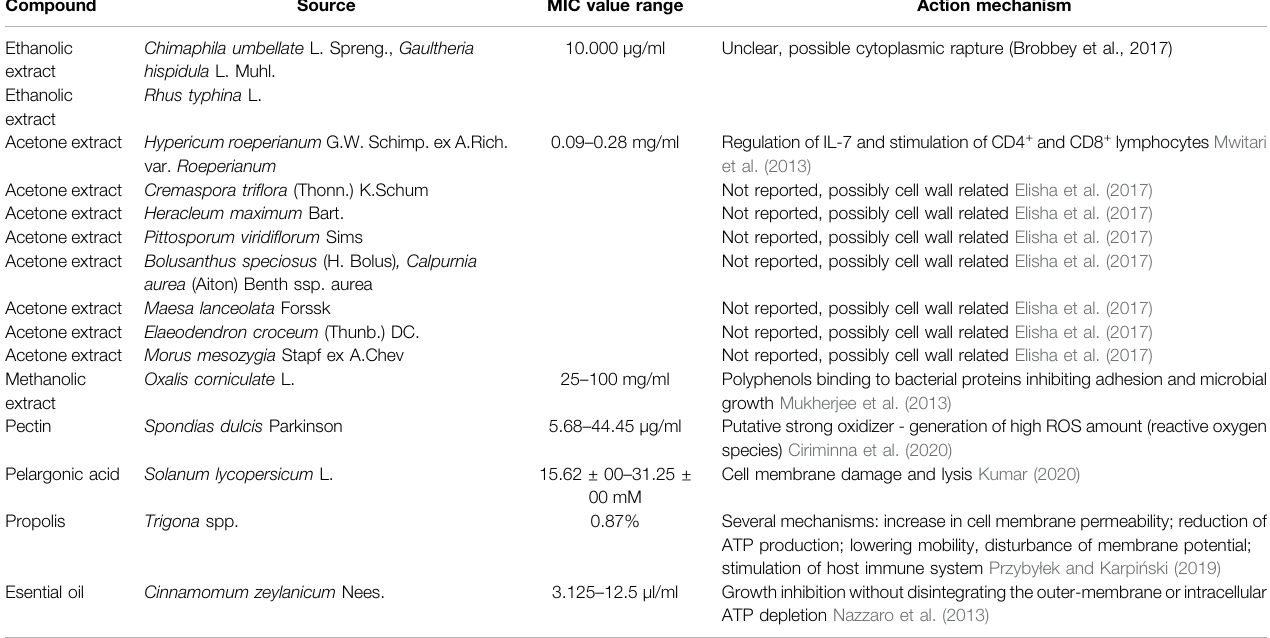
TABLE 1 | Mechanism of action of plant compounds against Gram-negative